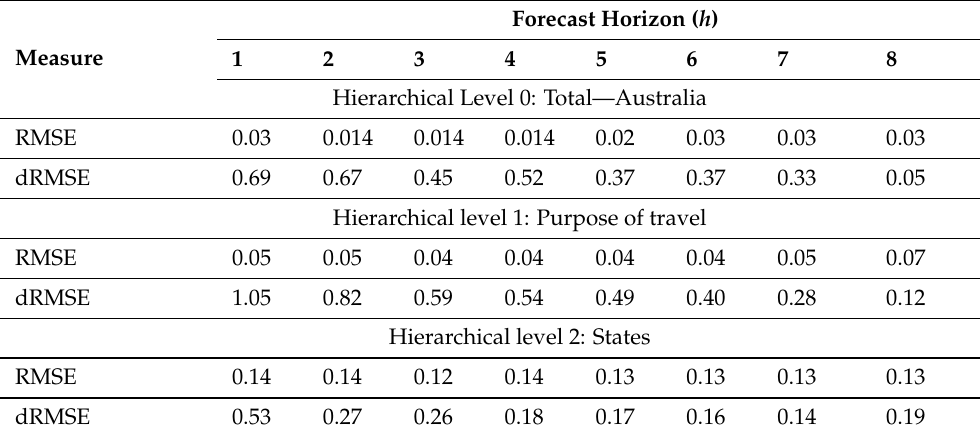
Forecast Horizon ( h